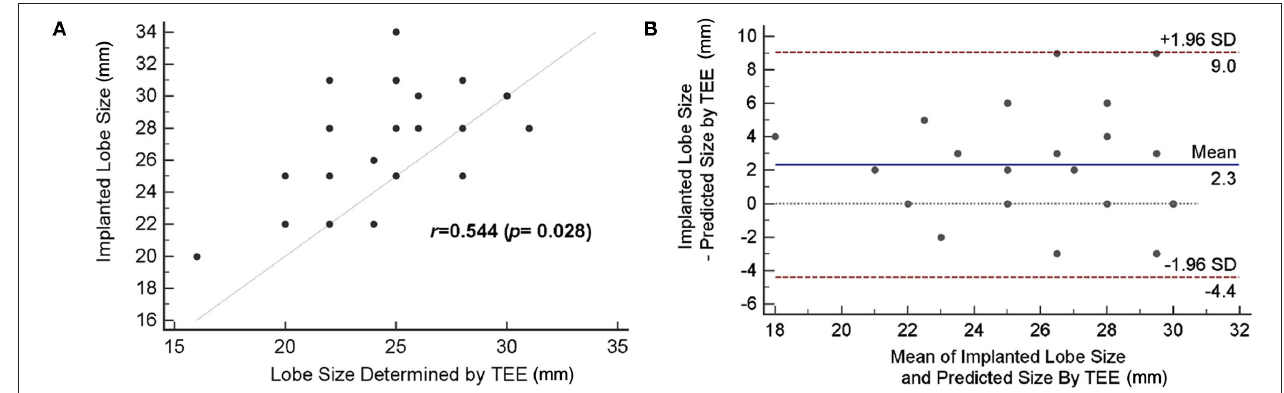
FIGURE 4 | Accuracy of device size prediction based on transesophageal echocardiography (TEE). (A) Correlation of TEE-based predicted size and actually implanted lobe size. (B) The Bland–Altman plot comparing the predicted size by TEE and actual device size.